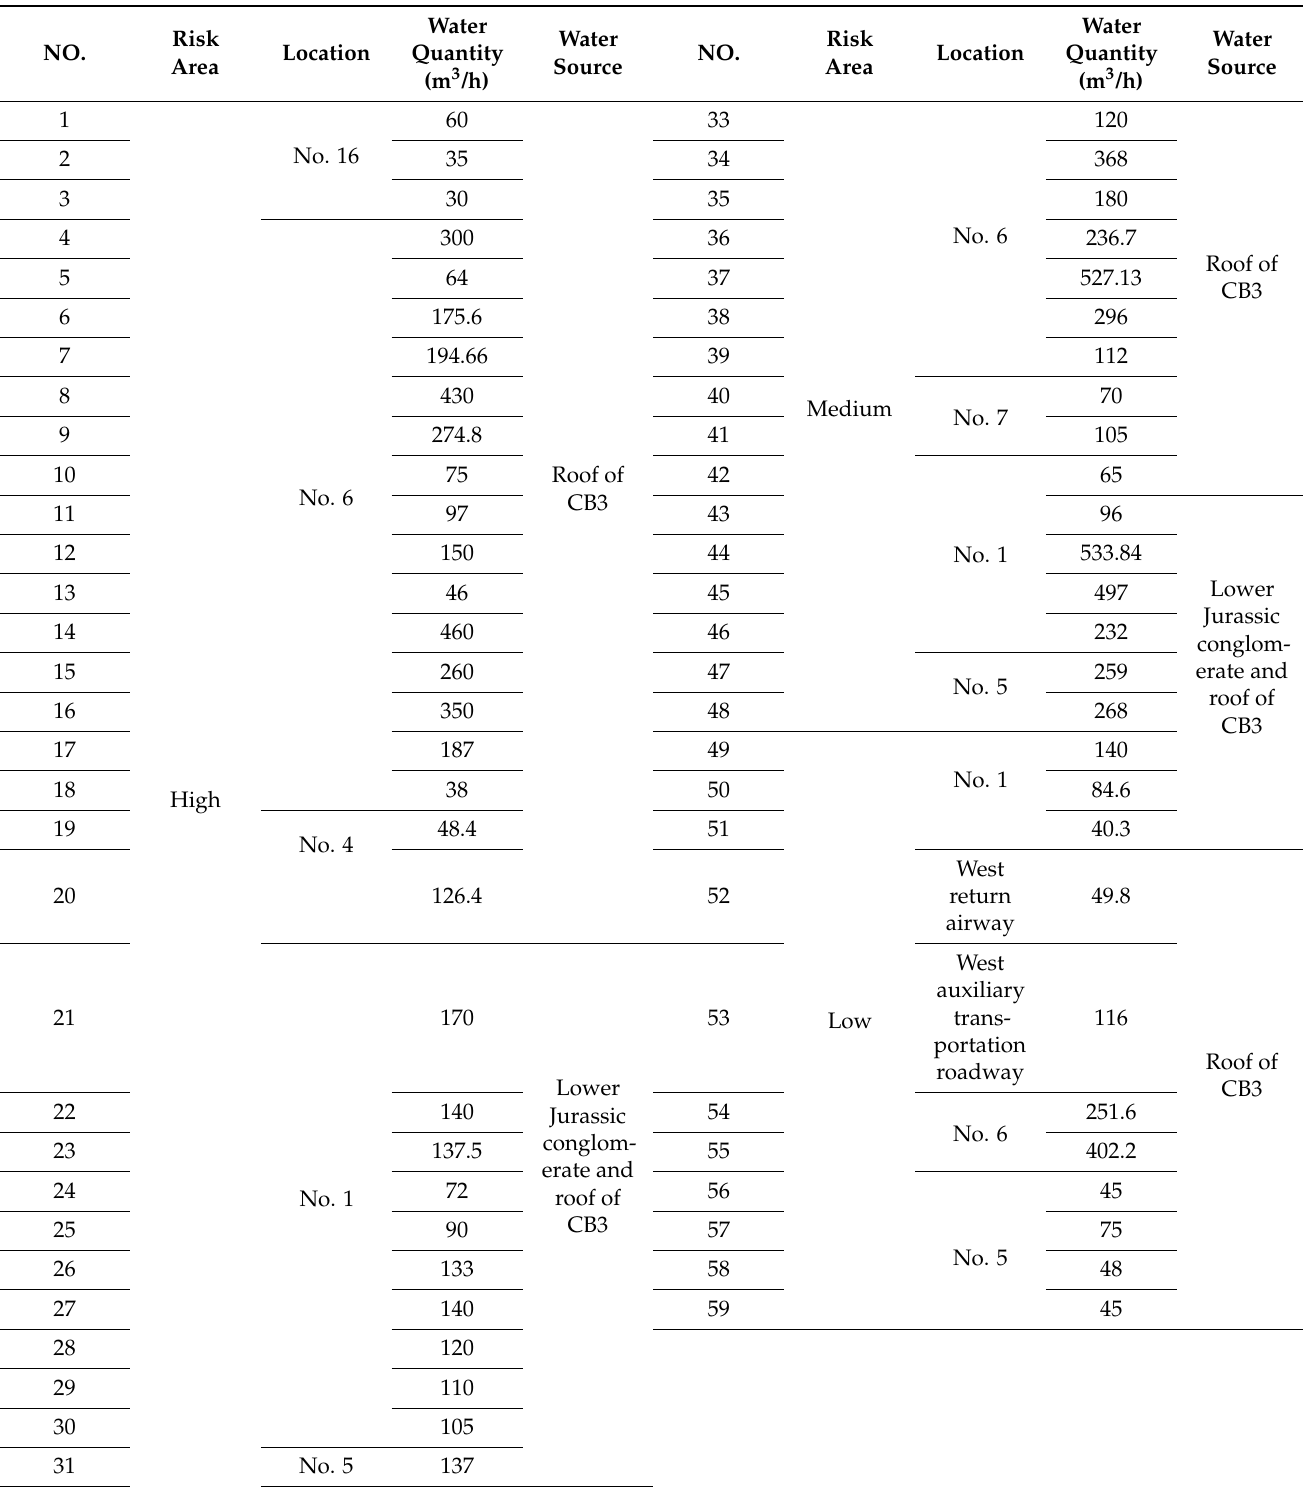
Table 6. Water inrush points (WIPs) located in the